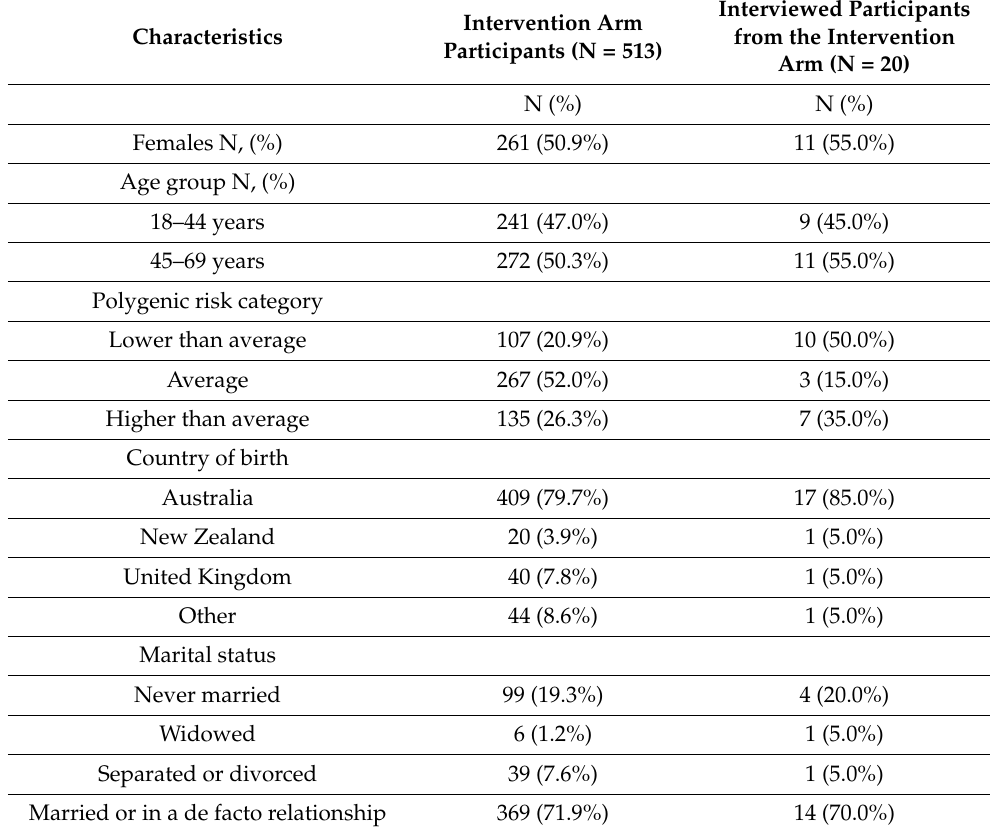
Table 1. Participant